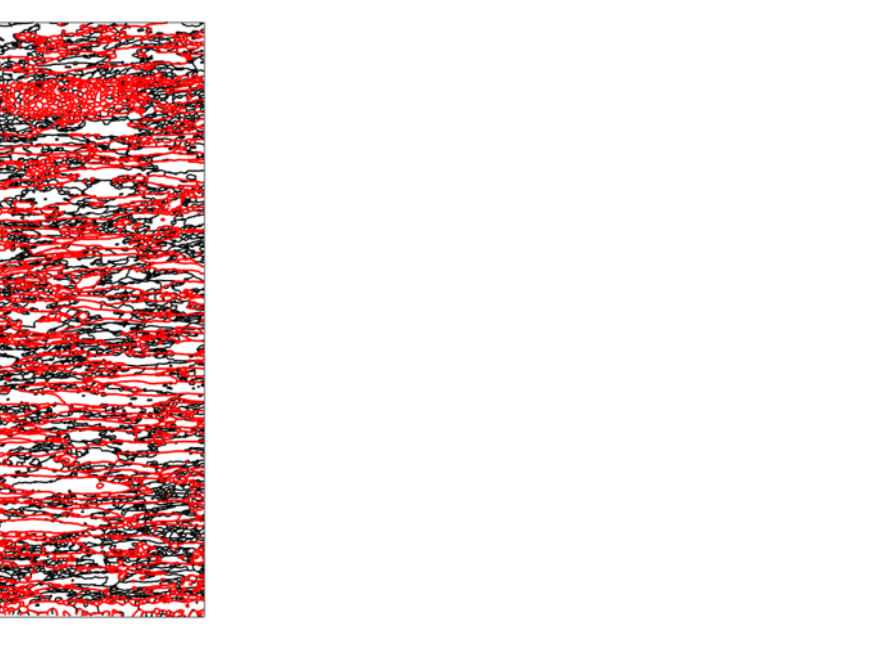
Figure 1. Using a cutoff angle θ m of 15 degrees, low (LAGB) and high (HAGB) angle boundaries can be distinguished. HAGBs are shown in red and LAGBs in black. The minimum threshold size for a grain is 2 px. The UAM interface is visible near the top of the image as a collection of dense